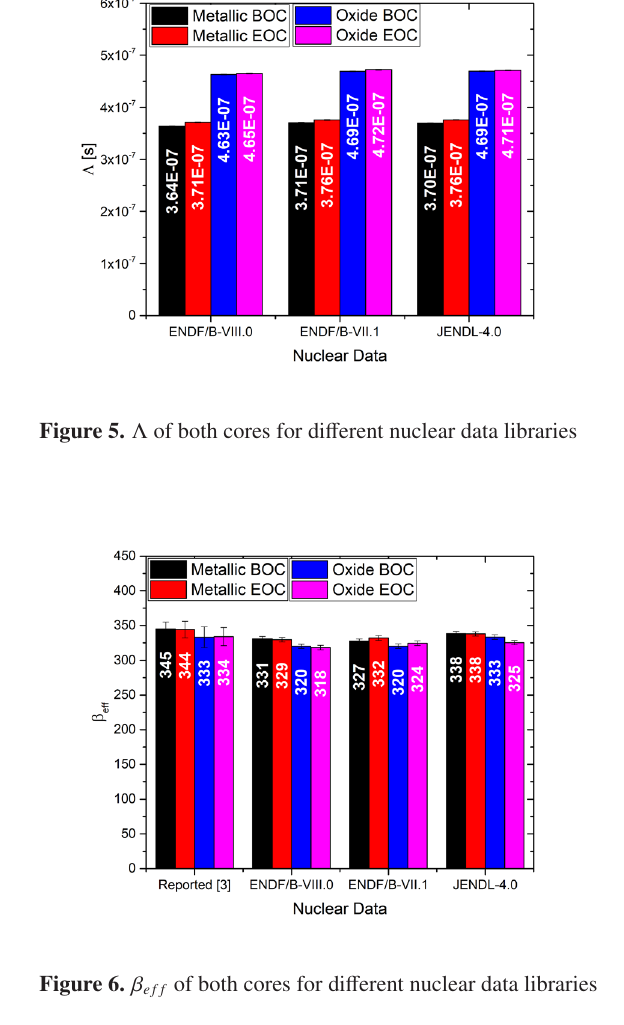
Table 1. k of metallic core at BOC and EOC